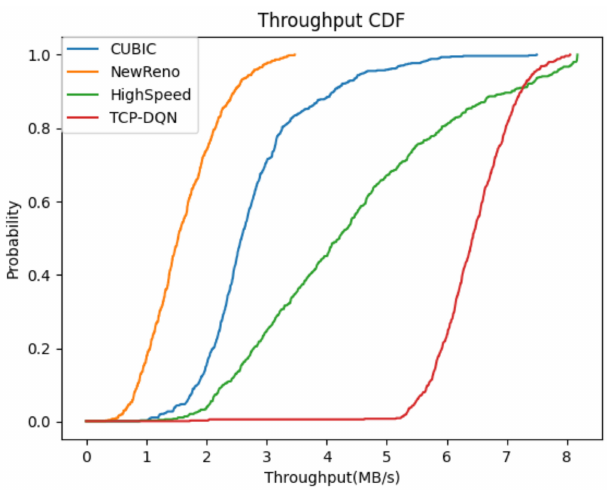
Figure 5. Comparison of cumulative probability density distribution of